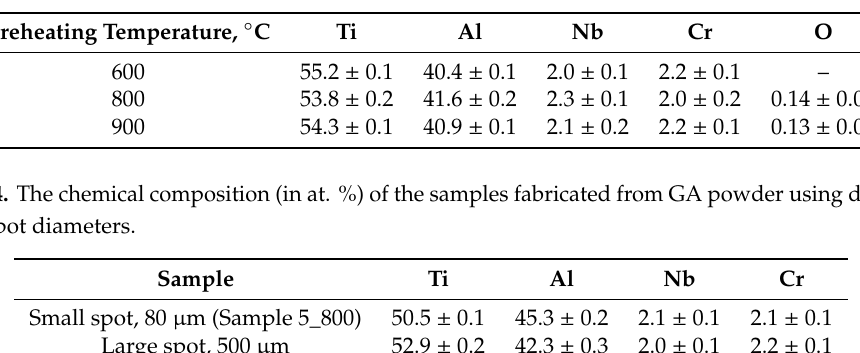
Table 3. The chemical composition (in at. %) of the samples fabricated from MAPS powder at di ff erent preheating temperatures.